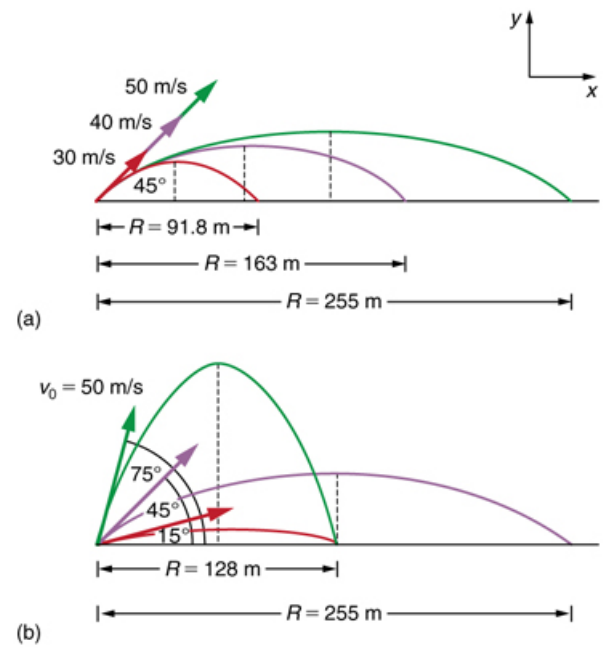
Fig. 5 The relationship between shooting angle and basketball flying